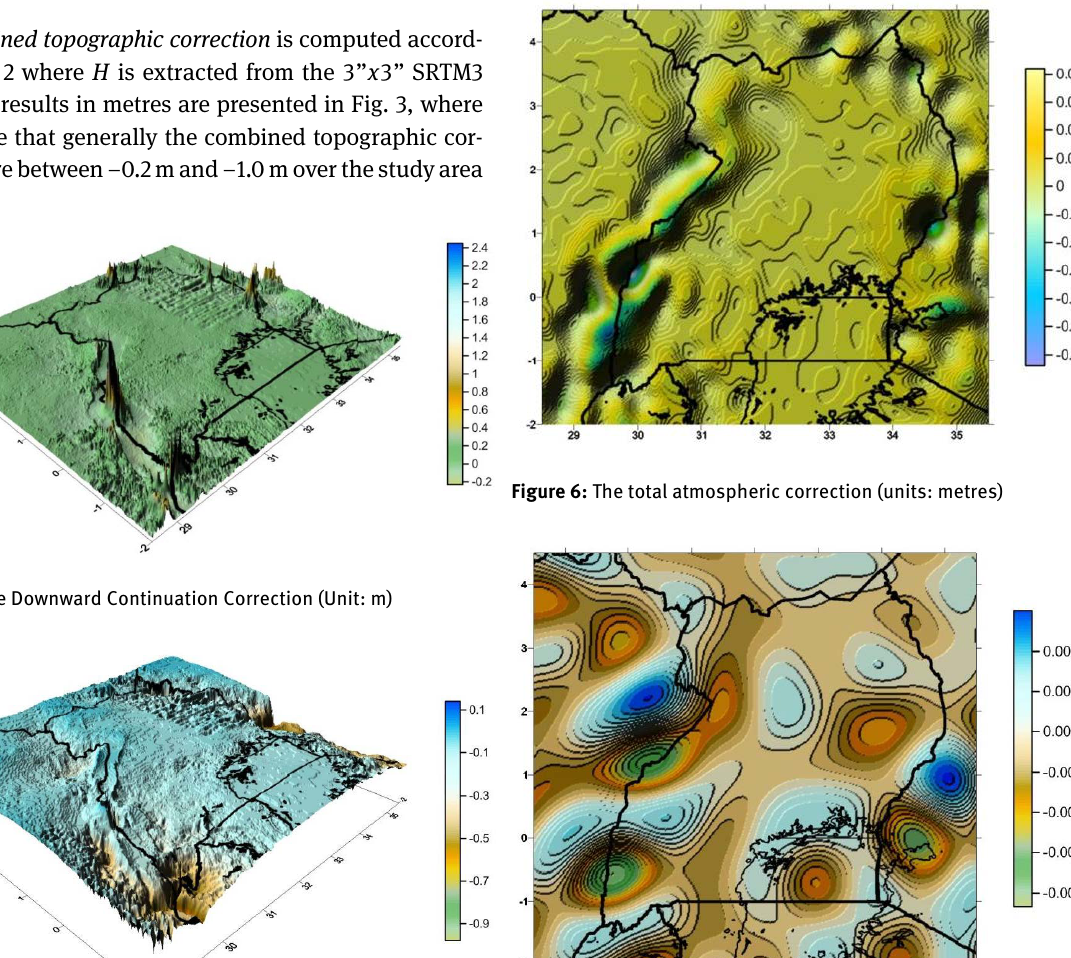
Figure 5: The total topographic effect (Units: metres)